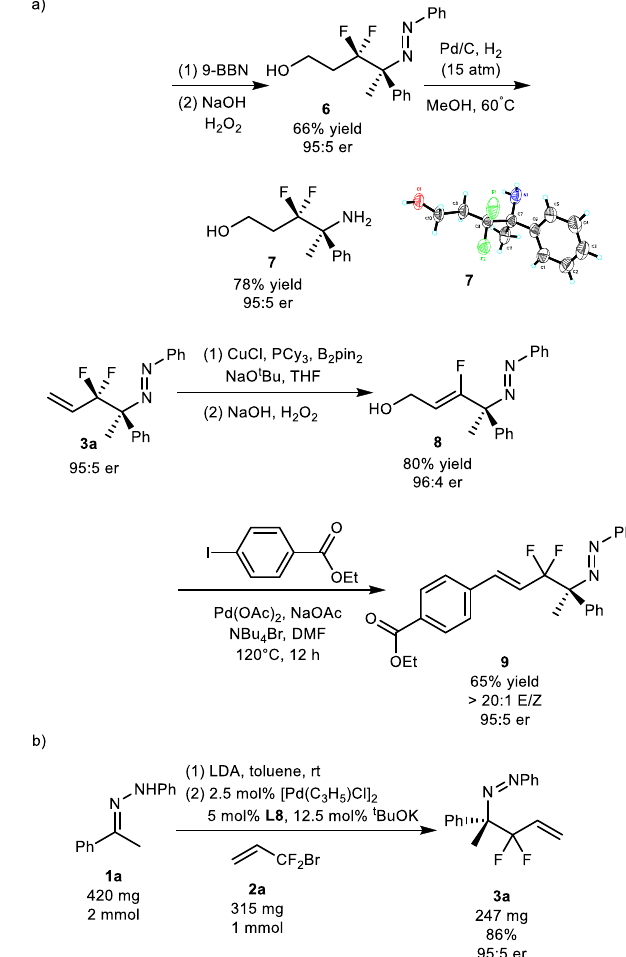
Fig. 7 Transformation of reaction product and one mmol scale reaction. a Reactions of 3a under different reaction conditions. b Pd-Catalyzed asymmetric umpolung allylation of hydrazine 1a with BDFP 2a on mmol-